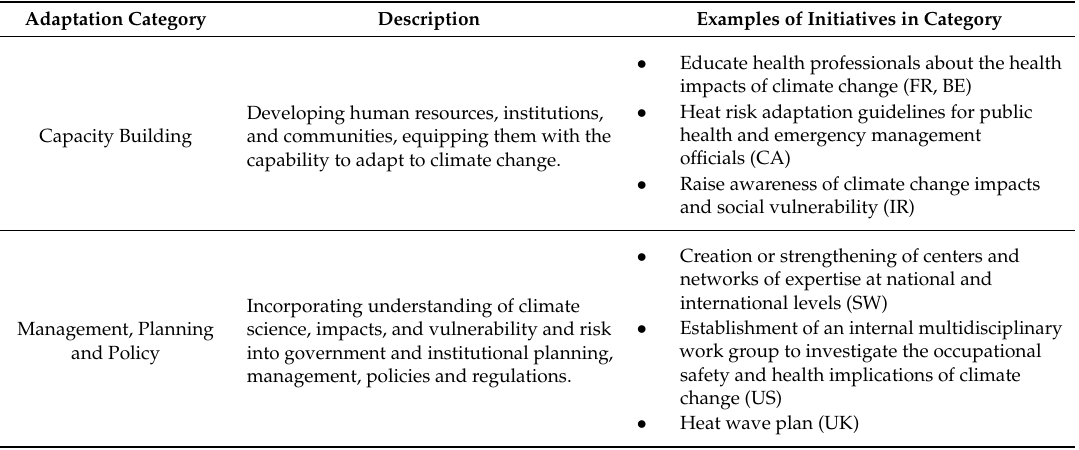
Table 1. Adaptation